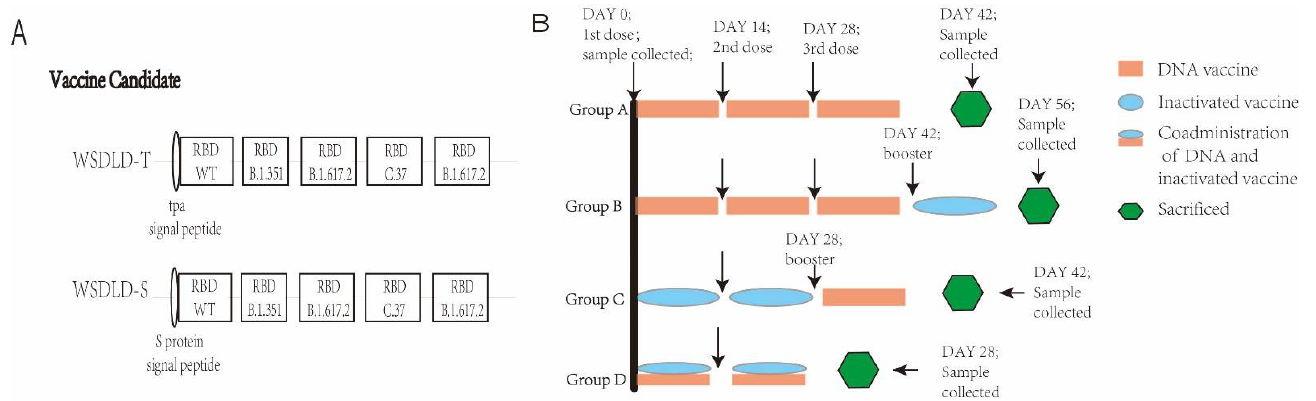
Figure 1. ( A ) Schematic diagram of two DNA vaccine candidate constructs. RBD: receptor binding domain. ( B ) Animal immunization and sample collection procedures. The DNA vaccines all con- tained two RBD genes of B.1.617.2 (Delta